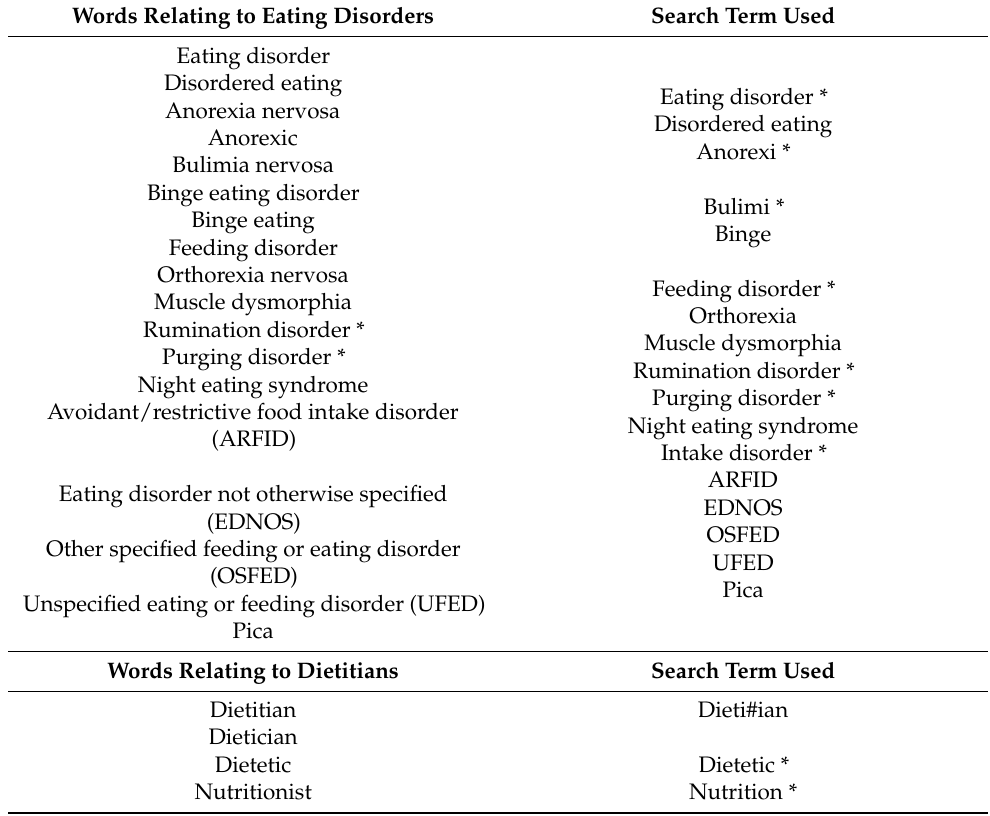
Table A1. Search terms used in the systematic search of the electronic